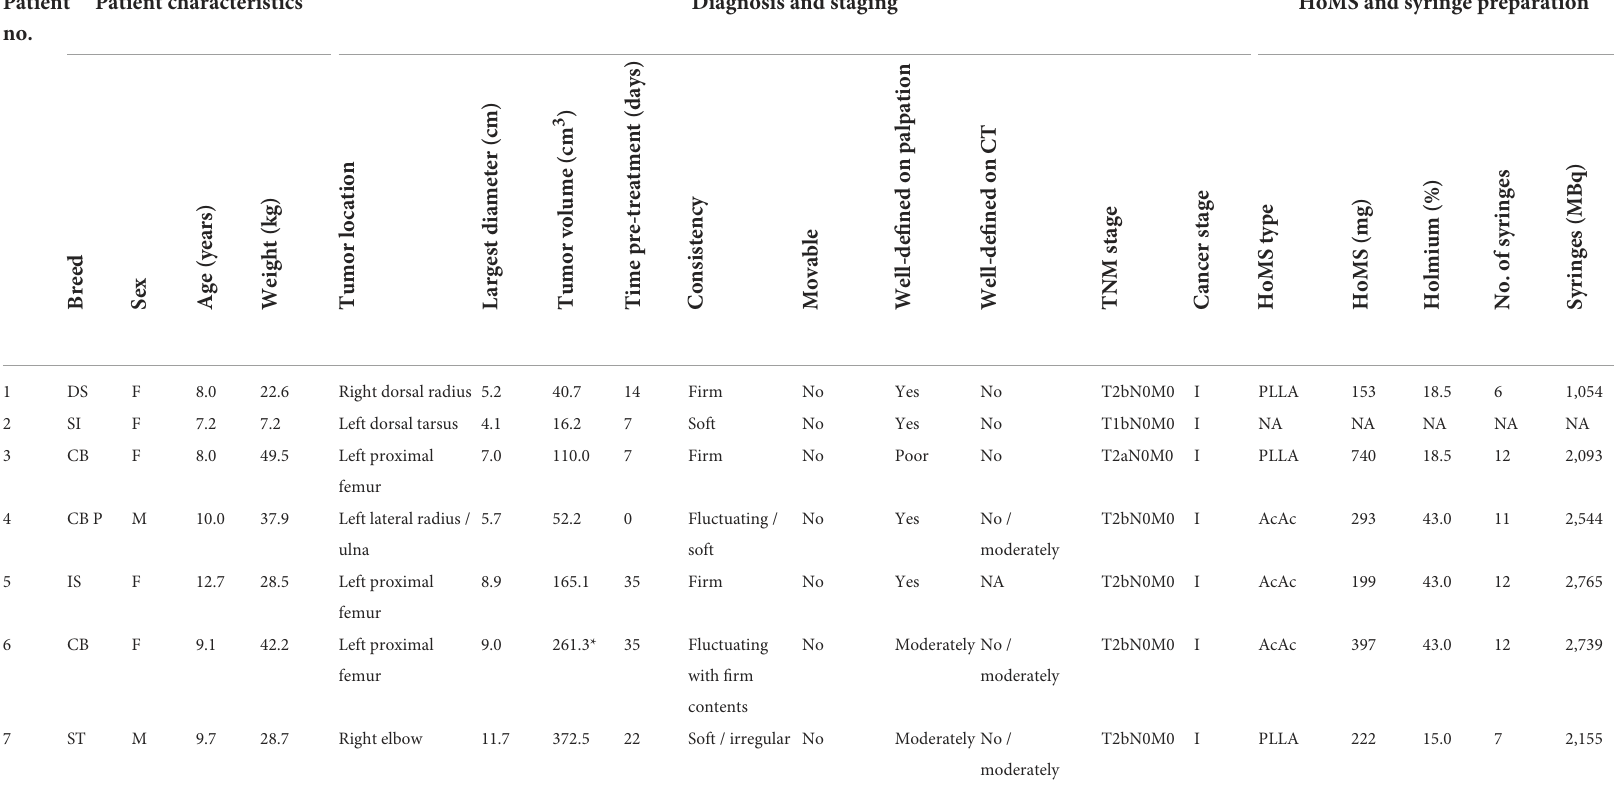
TABLE 1 Patient characteristics and preparation of holmium-166 microbrachytherapy of seven canine patients with soft tissue sarcoma. Patient Patient characteristics Diagnosis and staging HoMS and syringe no.